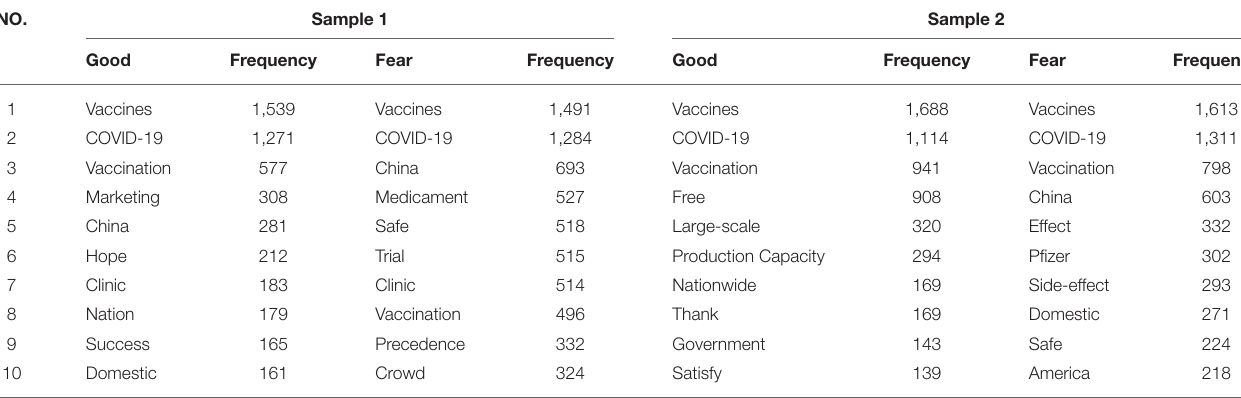
TABLE 4 | High-frequency words of “good” and “fear” in the two samples. NO. Sample 1 Sample